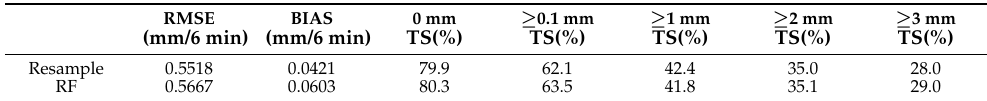
Table 11. Comparison of RF loss and re-sampling